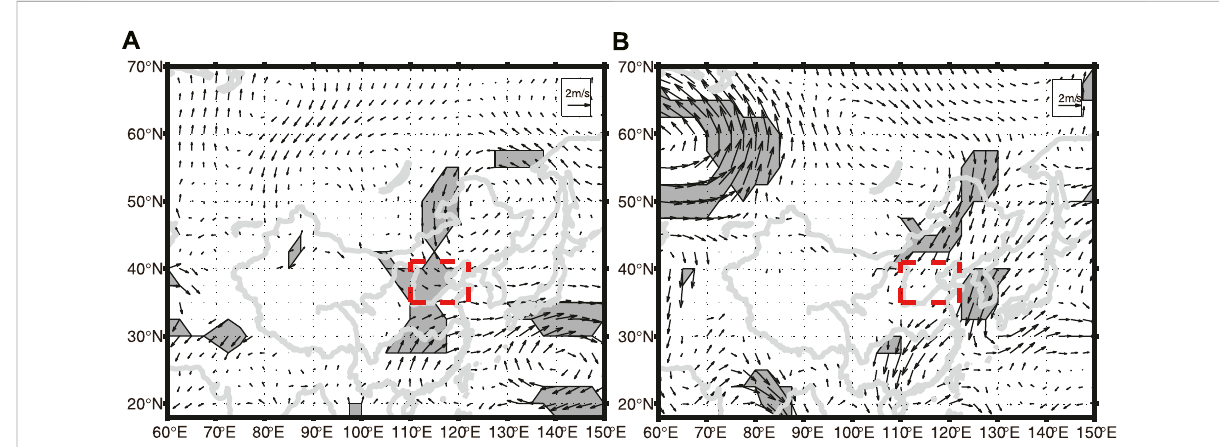
FIGURE 7 Regressionresults ofwindvector at850 hPa usingthenormalizedPDOindexduring (A) 1979 – 2005and (B) 2006 – 2021. Shadedareasindicate regression reaching 95% con fi dence levels according to Student ’ s t -test. The box shows the region of North